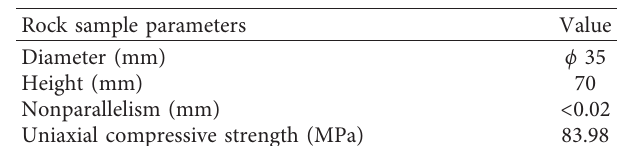
Table 3: Rock sample